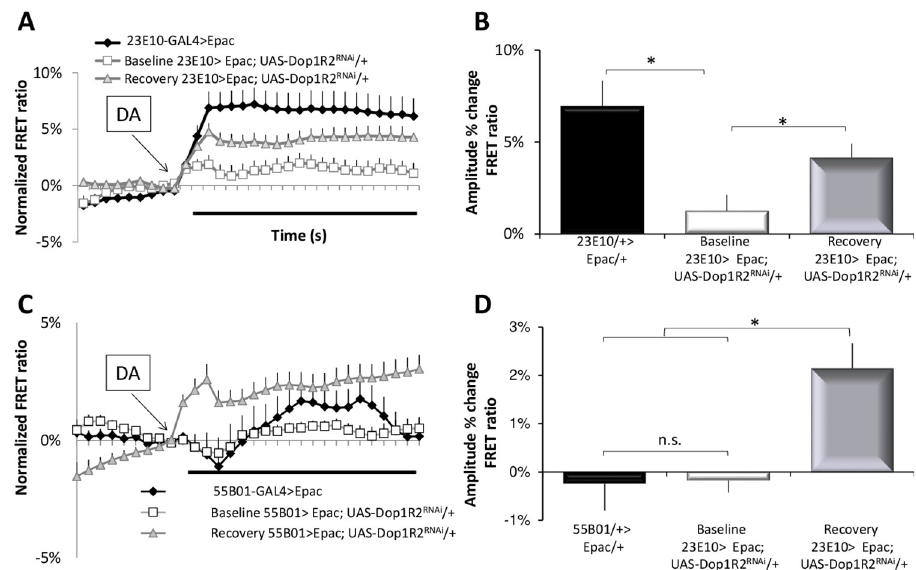
Fig 7. Starvation alters the response properties of sleep-promoting neurons. ( A ) R23E10 cells expressing the cAMP sensor Epac1-camps respond to 3 × 10 − 5 M DA (black line; n = 22 neurons); the response is dramatically reduced in R23E10 > UAS-Epac1-camps; Dop1R2 RNAi (white line; n = 25 neurons) and partially restored during recovery from 18 h of starvation (gray line; n = 29 neurons). ( B ) Quantification of a; F[2,73] = 7.7, p = 0.0009, � p < 0.05, modified Bonferroni test. ( C ) The response of R55B01 > UAS-Epac1-camps (black; n = 13) and R55B01 > UAS-Epac1-camps; Dop1R2 RNAi (white; n = 19) neurons to DA is very low; following recovery from starvation, the response of R55B01 neurons to DA increased (gray line; n = 20). ( D ) Quantification of c; F[2,49] = 9.9, p = 0.0002, � p < 0.05, modified Bonferroni test. Error bars represent SEM. Underlying data is in S7 Data and S1 Datasheet. cAMP, cyclic adenosine monophosphate; DA, dopamine.